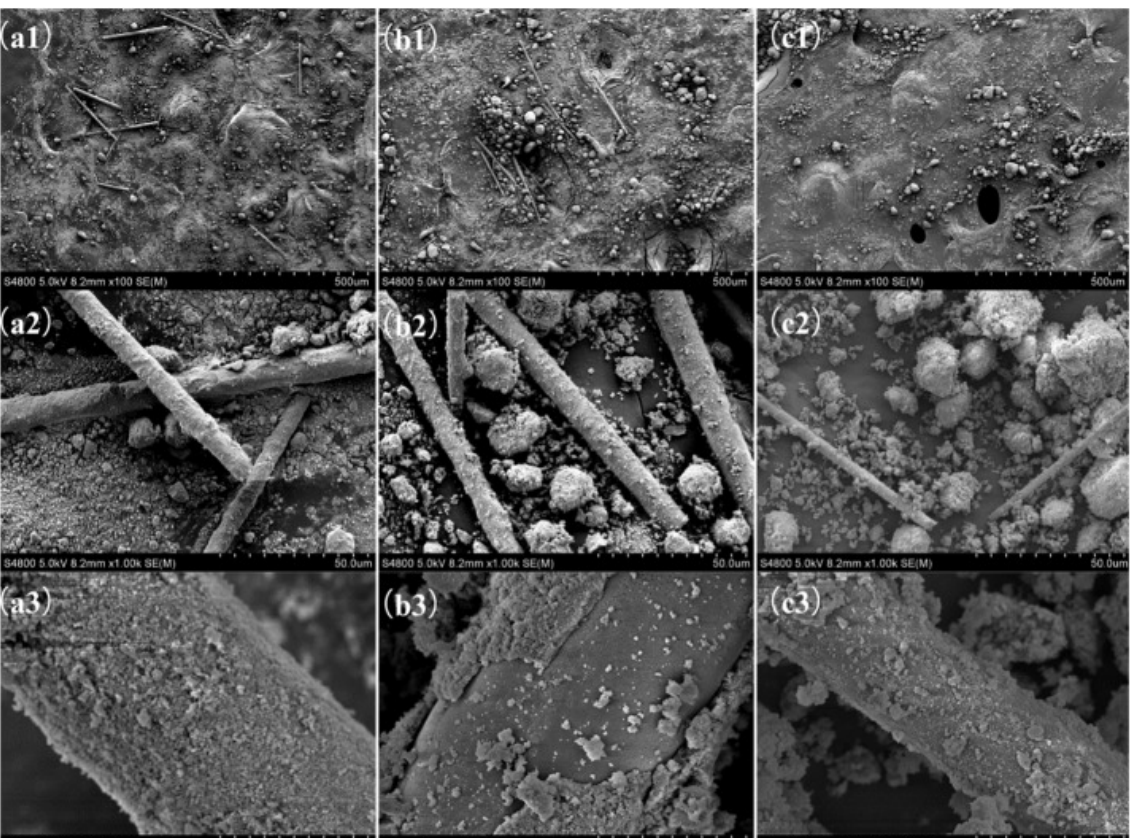
Figure 2. SEM images of ( a ) the original catalyst, ( b ) the catalyst treated by the premixing method and ( c ) the catalyst treated by the common method (from 1 to 3 at 100 × , 1000 × and 10,000 × , respectively). Reproduced with permission [59]. Copyright 2018, Elsevier.